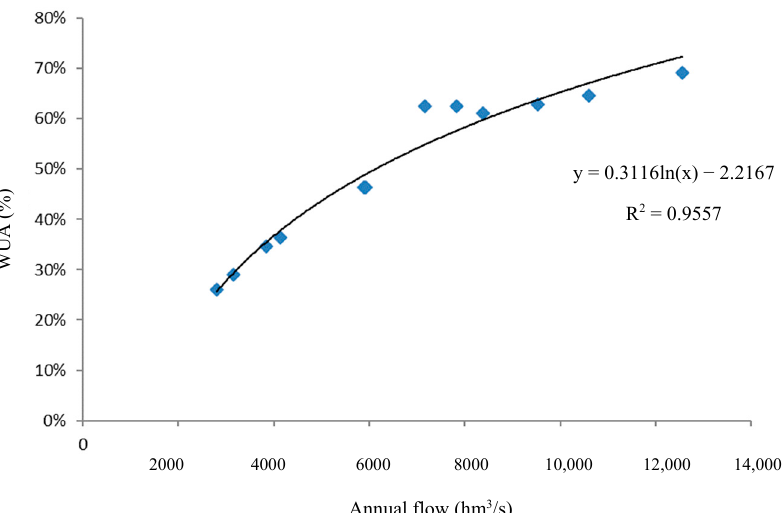
Figure 3. WUA/Flow curve to reach a proportion greater than 50% between native and non-native fish species in the lower Ebro River. Source: modified from CSTE [19] .